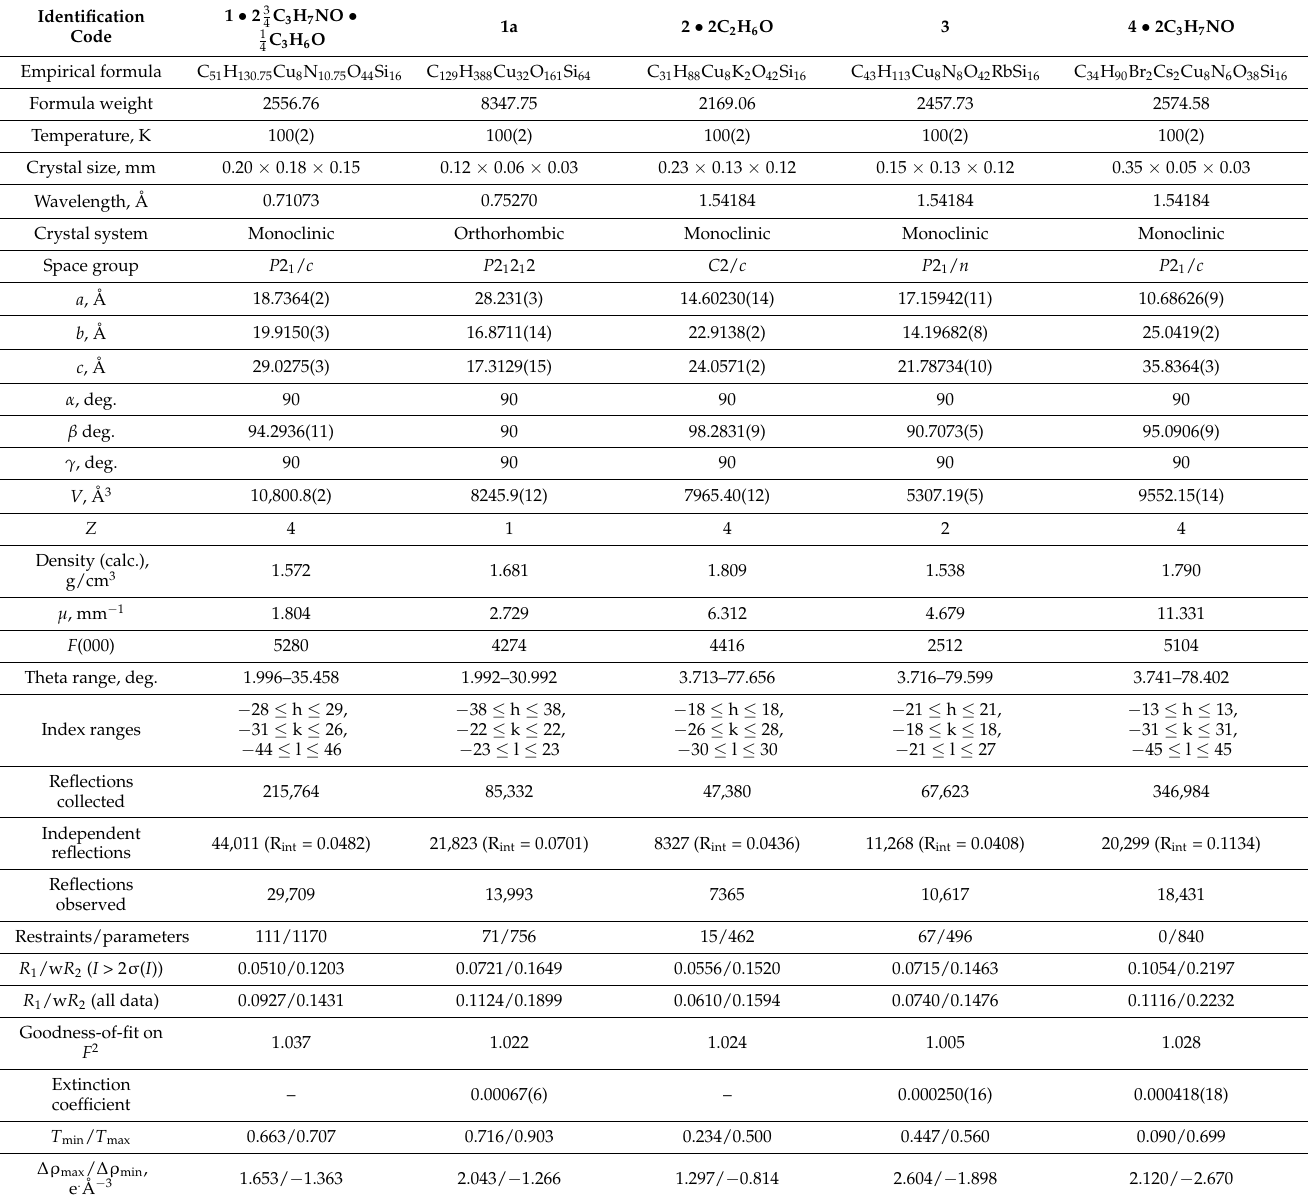
Table 1. Crystal Data and Structure Refinement for Compounds 1–4